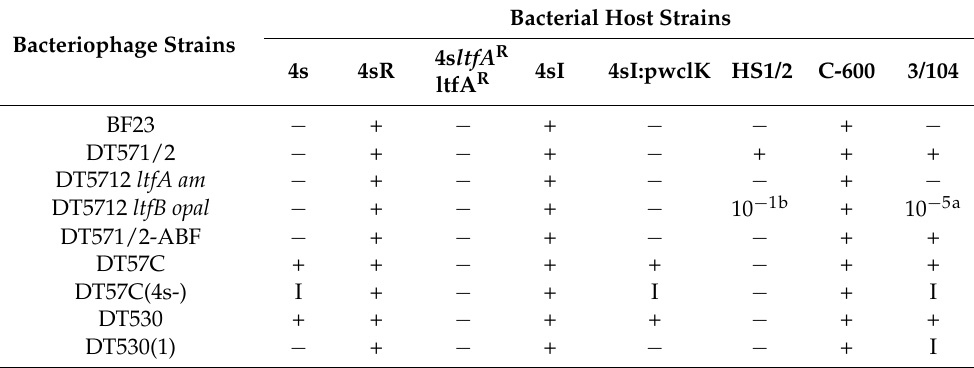
Table 1. Efficiency of plating (EOP) of bacteriophages and their mutants on different E. coli host strains. The strain 4sR ltfA R is a mutant of E. coli 4sR selected for resistance for DT571/2 ltfA am phage mutant (two independent clones having different mutations in btuB gene had the same phenotype so this strain designation stays for both of